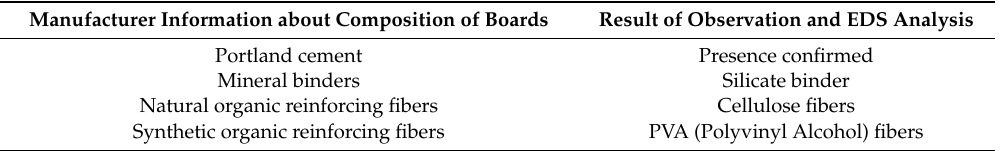
Table 2. Composition data of the tested